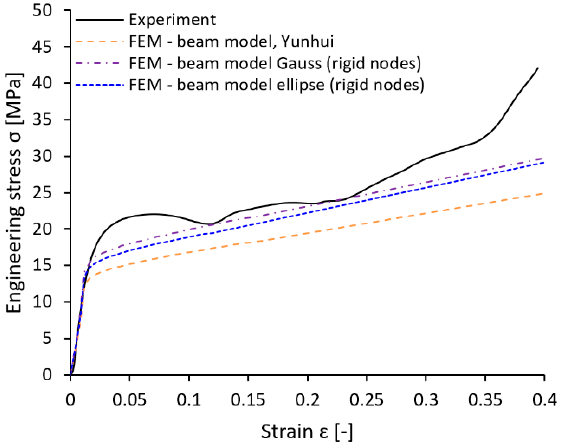
Figure 18. ( a ) Geometry of verification part; ( b ) building configuration with oriented cross-section imperfections.